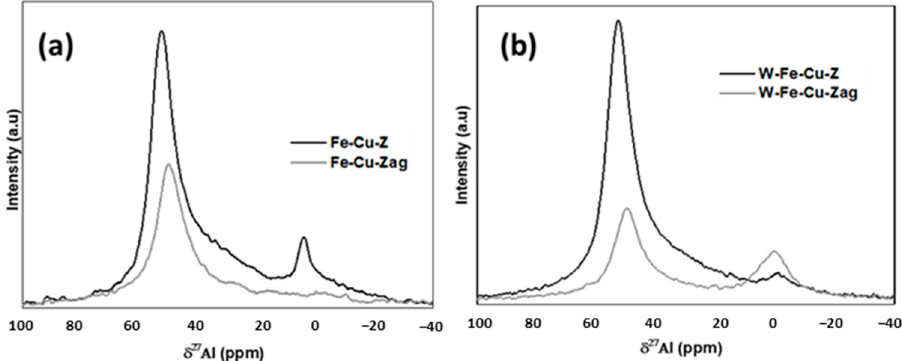
Figure 4. 27 Al NMR spectra of fresh and aged ( a ) Fe-Cu-Z and ( b ) W-Fe-Cu-Z.